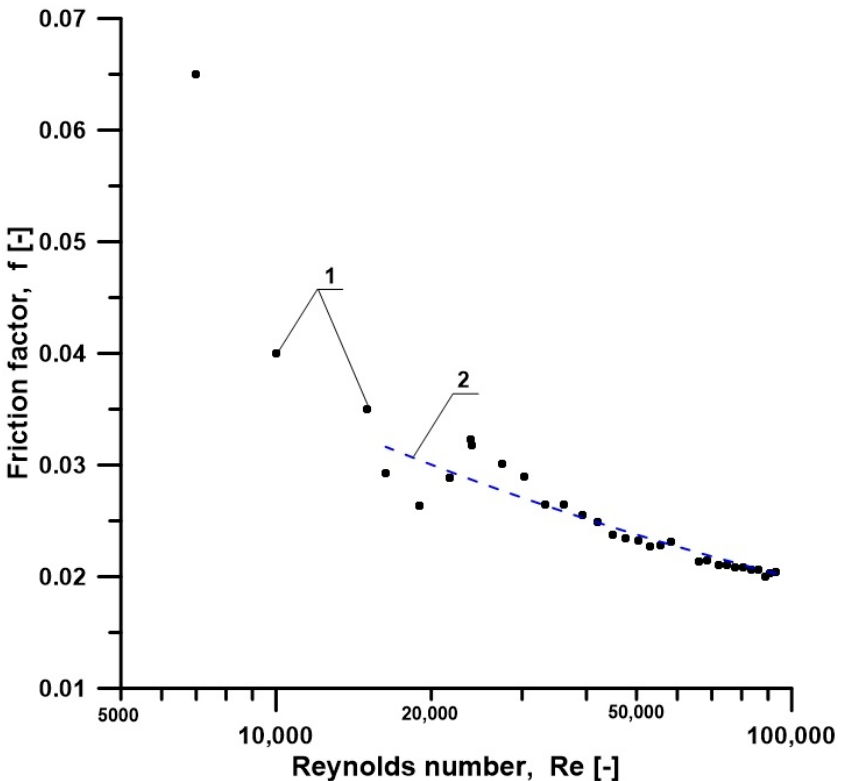
Figure 5. Friction factor values obtained experimentally; 1—experimental data; 2—values obtained from the proposed Equation (6).